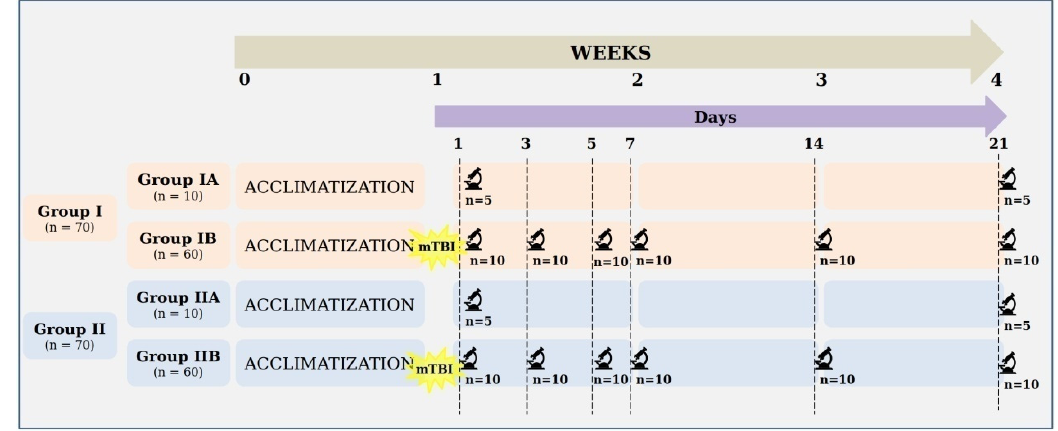
Figure 1. Detailed experimental design.